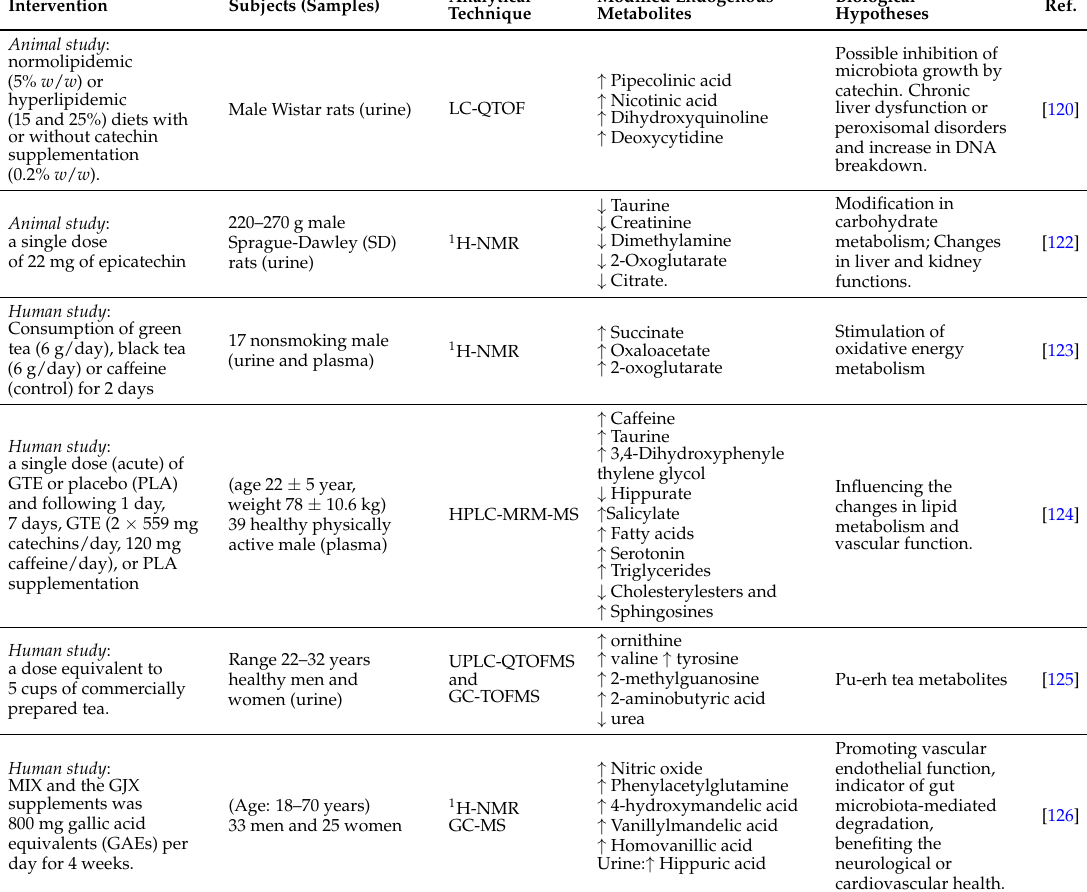
Table 2. Catechin intake resulting in endogenous metabolite